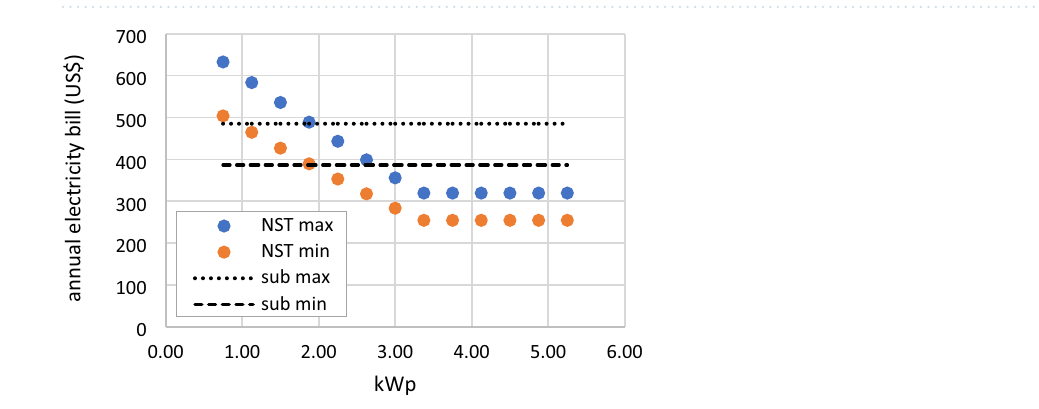
Figure 14. NPV and annual revenue of RSPP with different number of PV modules in BAU and NST scenario.